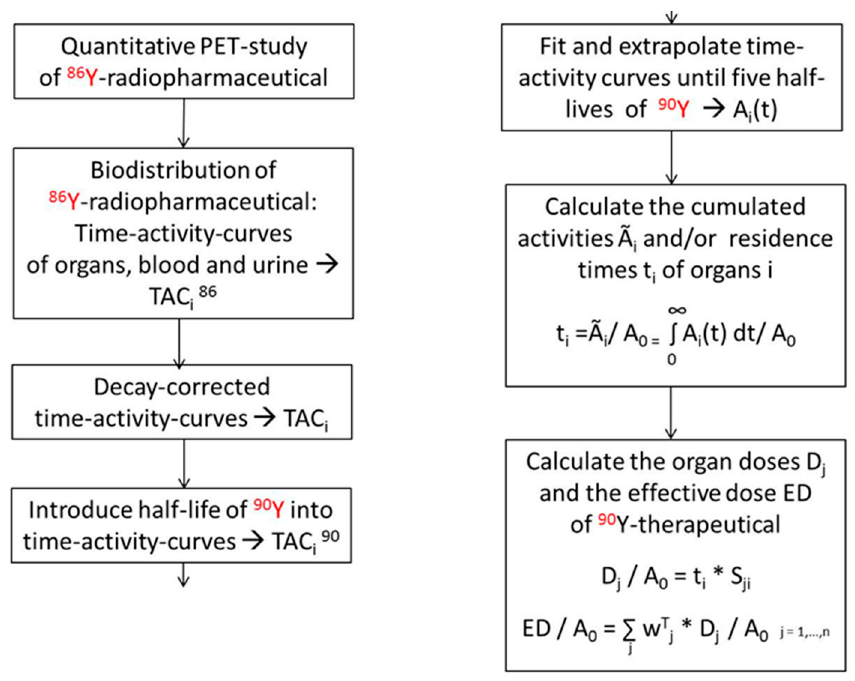
Figure 9. Block-diagram indicating the different steps from the PET study using the 86 Y-labelled radiopharmaceutical via the extraction of time-activity curves of relevant source organs and tissues to the calculation of the radiation doses D j caused by the 90 Y-labelled therapeutic to single target organs j and of the effective dose ED, which summarizes the radiation burden for the total body. The factor S ji comprises the mean absorbed dose in a target organ j received per decay in a source organ i. The tissue weighting factors w T j are defined by the International Commission on Radiological Protection (ICRP 103) [69]. Commonly, the number of doses is related to the total injected dose A 0